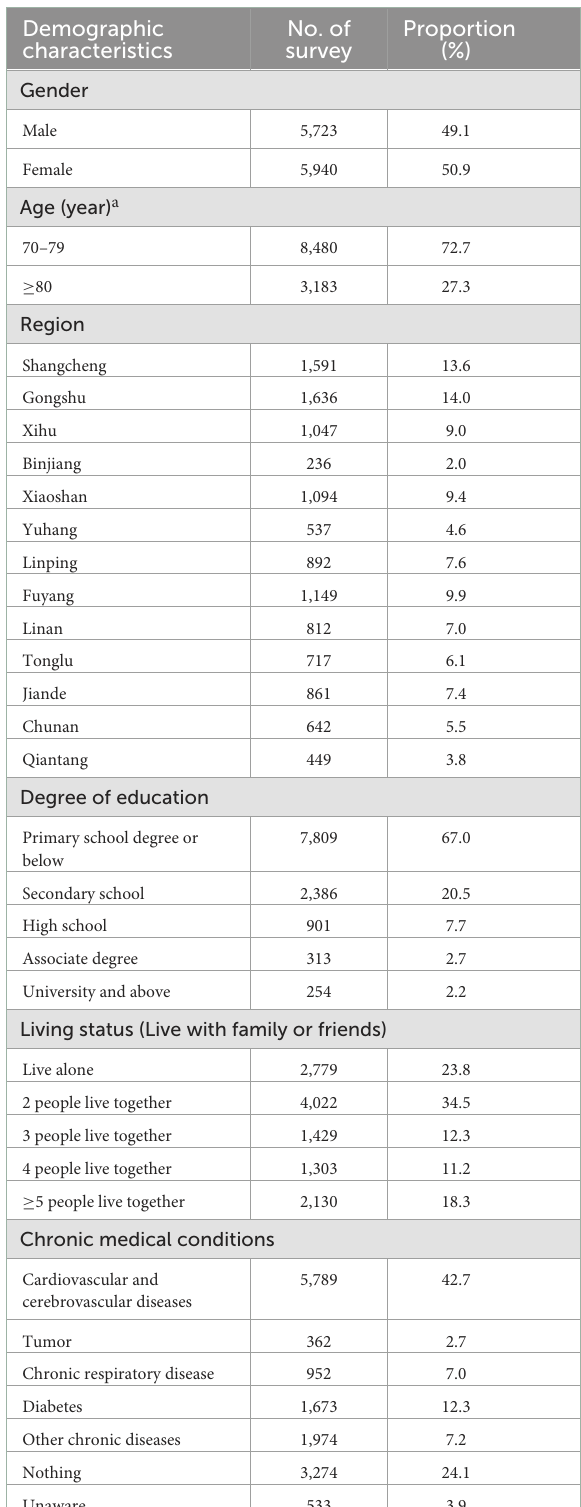
over 70 years old in Hangzhou. Demographic